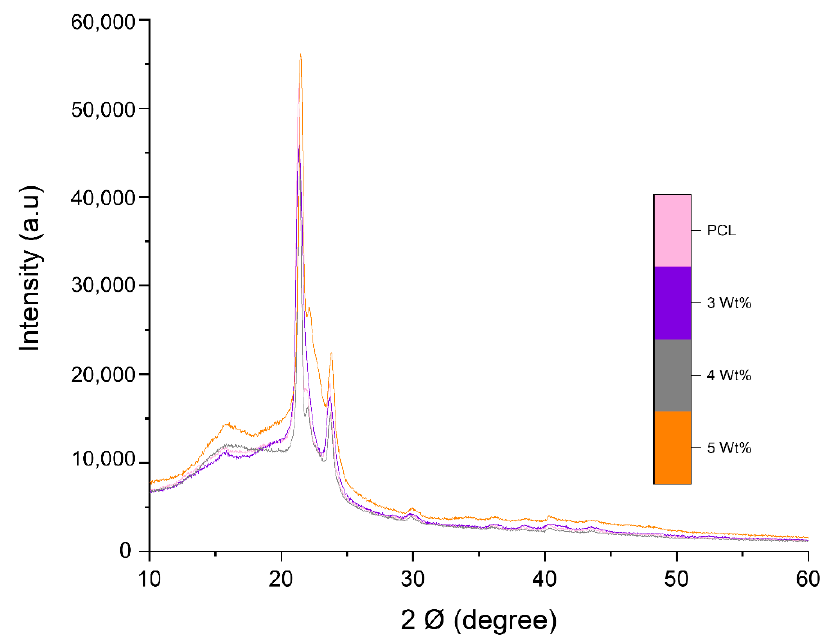
Figure 5. XRD patterns of pristine PCL fibres along with 3, 4 and 5 wt% PG-PCL fibres. The FTIR spectrum of PG has been reported previously [20]. The distinct peaks of PG were at 1735 and 1072 cm − 1 conforming to the C=O and C–O–C stretching vibrations from carbon and epoxy functional groups, respectively [31,64]. Figure 6 demonstrates the FTIR spectra of PCL and PG-loaded PCL. PCL showed a peak near 3500 cm − 1 and a strong band at 1745 cm − 1 , corresponding to hydroxyl and ester functional groups,